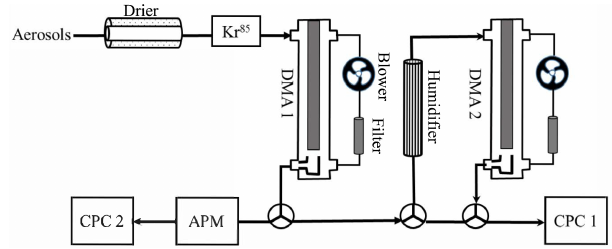
Figure 1. Schematic diagram of HTDMA-APM